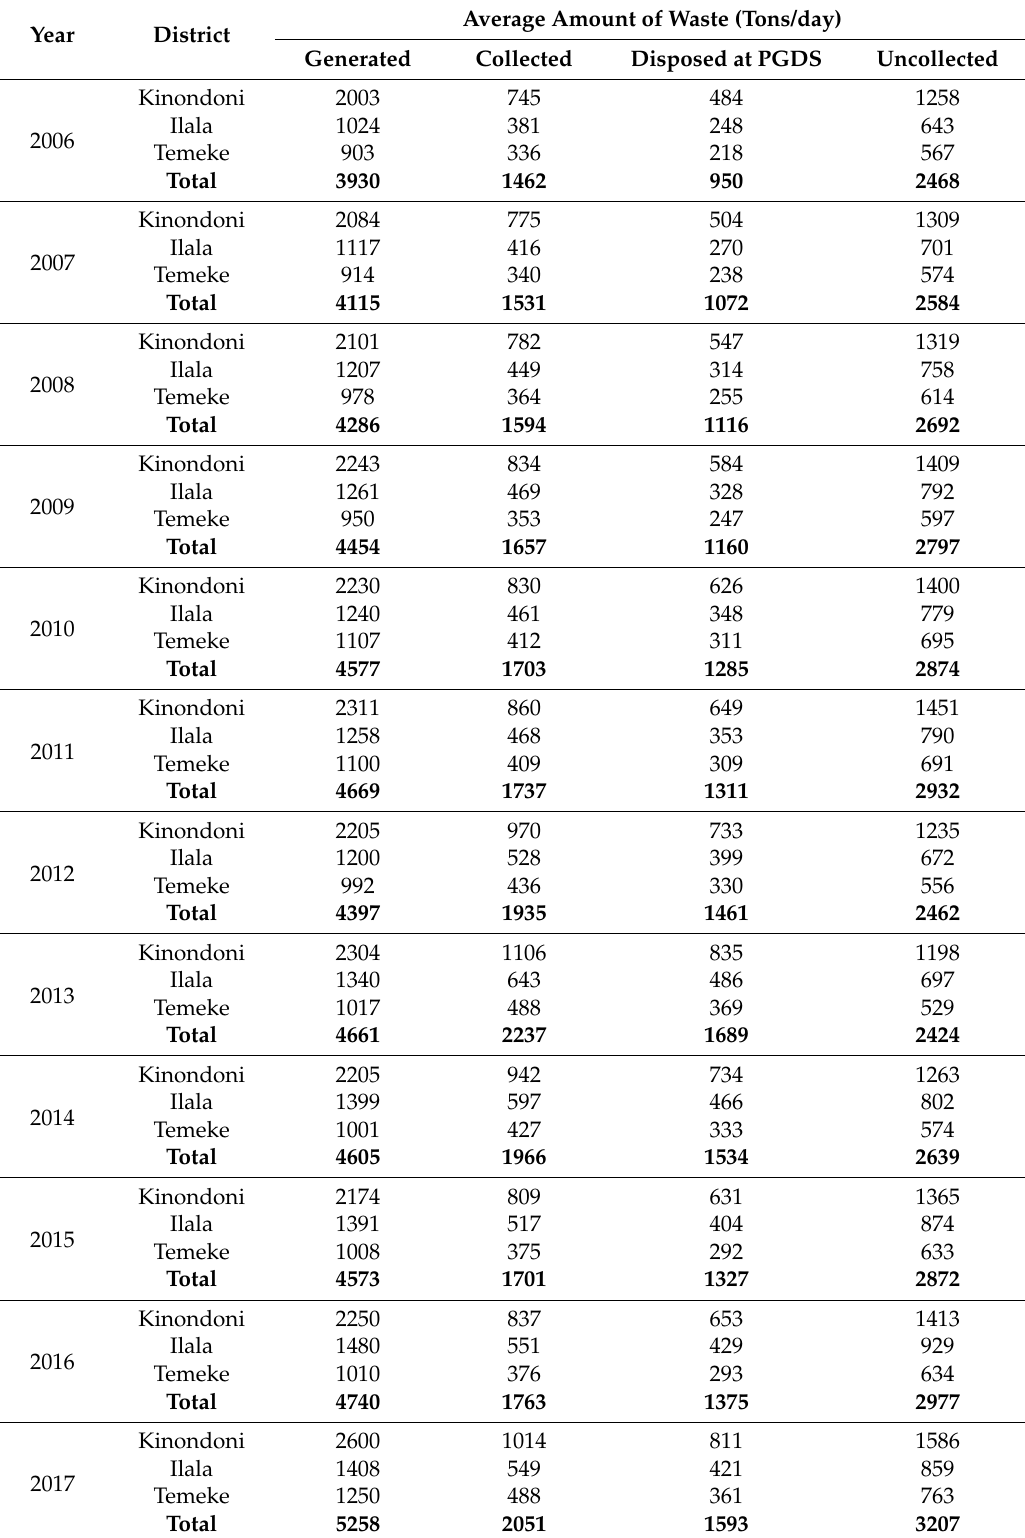
Table A2. MSW Management Status in Dar es Salaam